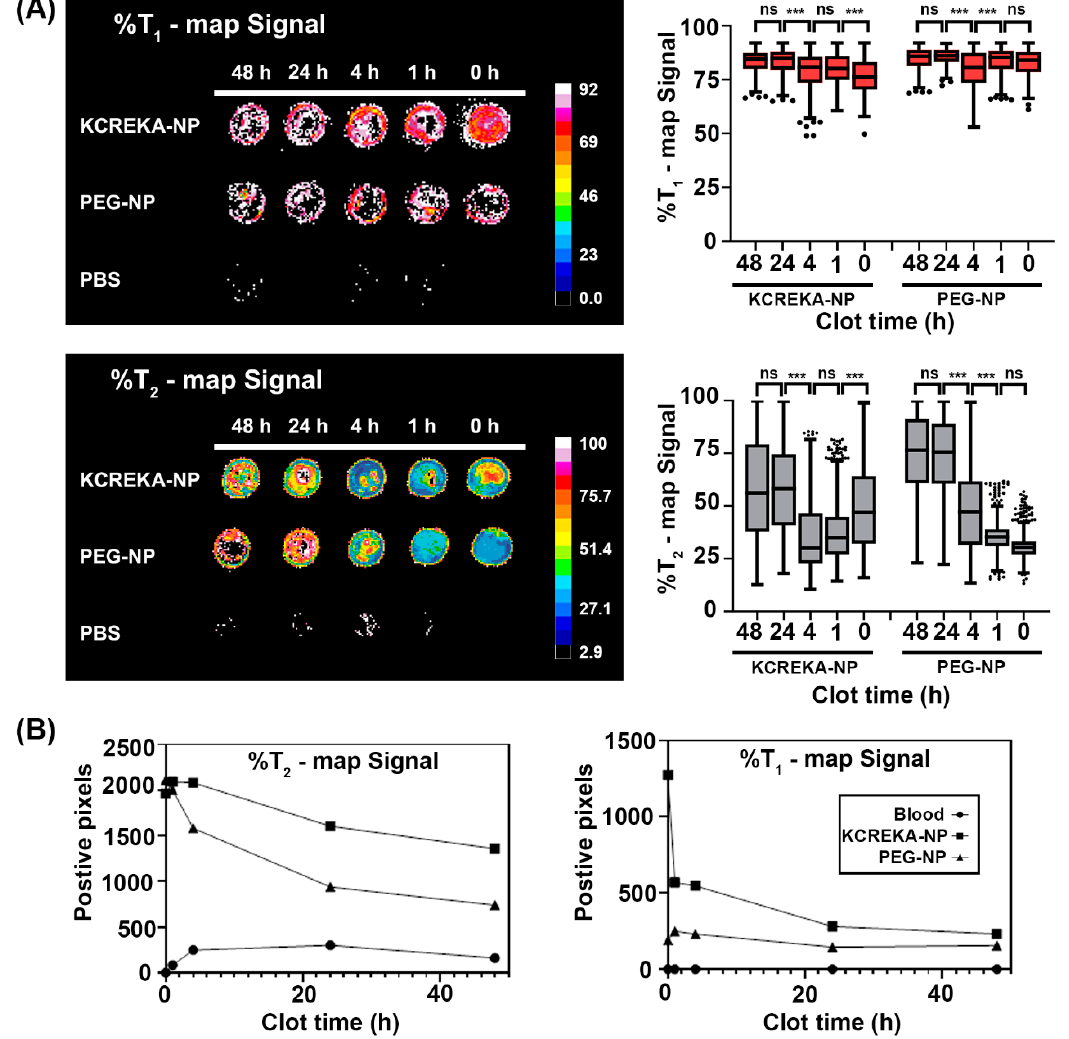
Figure 4. ( A ) MRI images and median values of the decrease in T 1 and T 2 weighted images in relation to the background signal for blood clots of 48, 24, 4, 1 h, and 0 h of age incubated with KCREKA-NPs, PEG-NPs, or PBS. ( B ) Number of positive pixels above the background signal for the T 1 and T 2 signals for blood clots of 48, 24, 4, 1 h, and 0 h of age incubated with KCREKA-NPs, PEG-NPs, or PBS. *** p < 0.001 using one way ANOVA followed by Kruskal-Wallis test.